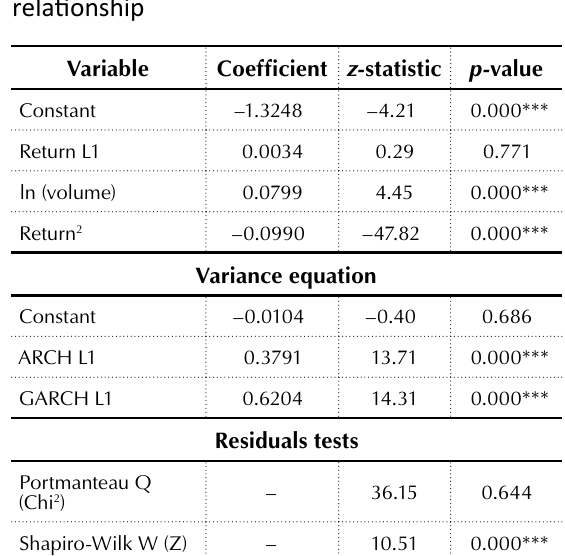
Table 3. GARCH (1,1) of volume, return, volatility